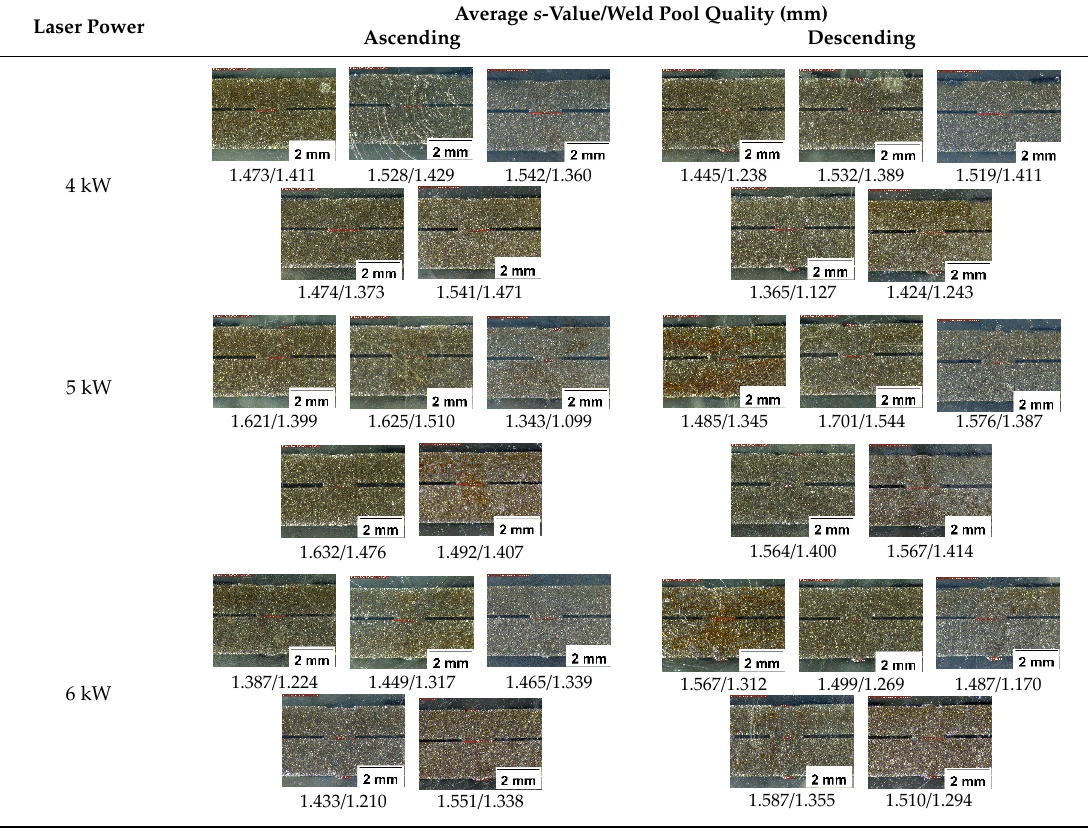
Figure 5. Main effect plots of the average s ‐ value and weld pool quality in terms of the travelling path for experiment ( a ) #1 ‐ 1 (laser power: 1.6, 1.8, and 2 kW, part ‐ to ‐ part gap: 0.3 mm) and ( b ) #1 ‐ 2 (laser power: 4, 5, and 6 kW, part ‐ to ‐ part gap: 0.3 mm). Table 8. ANOVA table for experiment #1 ‐ 1 (2 ‐ kW fiber laser welding system). Source Degree of Freedom Sum of Squares Mean Square F ‐ Ratio P ‐ Value Blocks